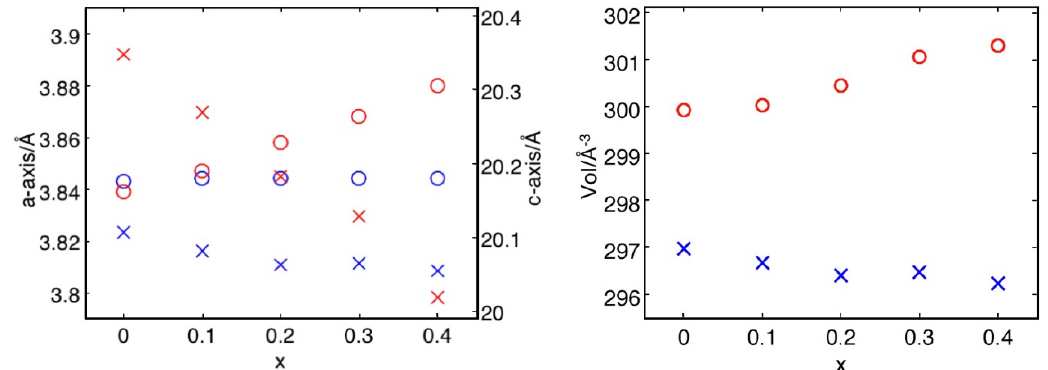
Figure 2. Unit cell parameters ( a = circles and c = crosses) ( left ) and volume ( right ) of Sr 3 − x Pr x (Fe 1.25 Ni 0.75 )O 7 −δ versus x for N 2 -annealed (red) and air-annealed (blue) compositions .